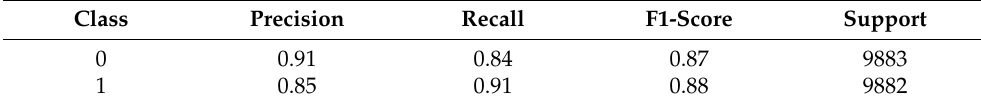
Table 9. The Results of the Model Validation.